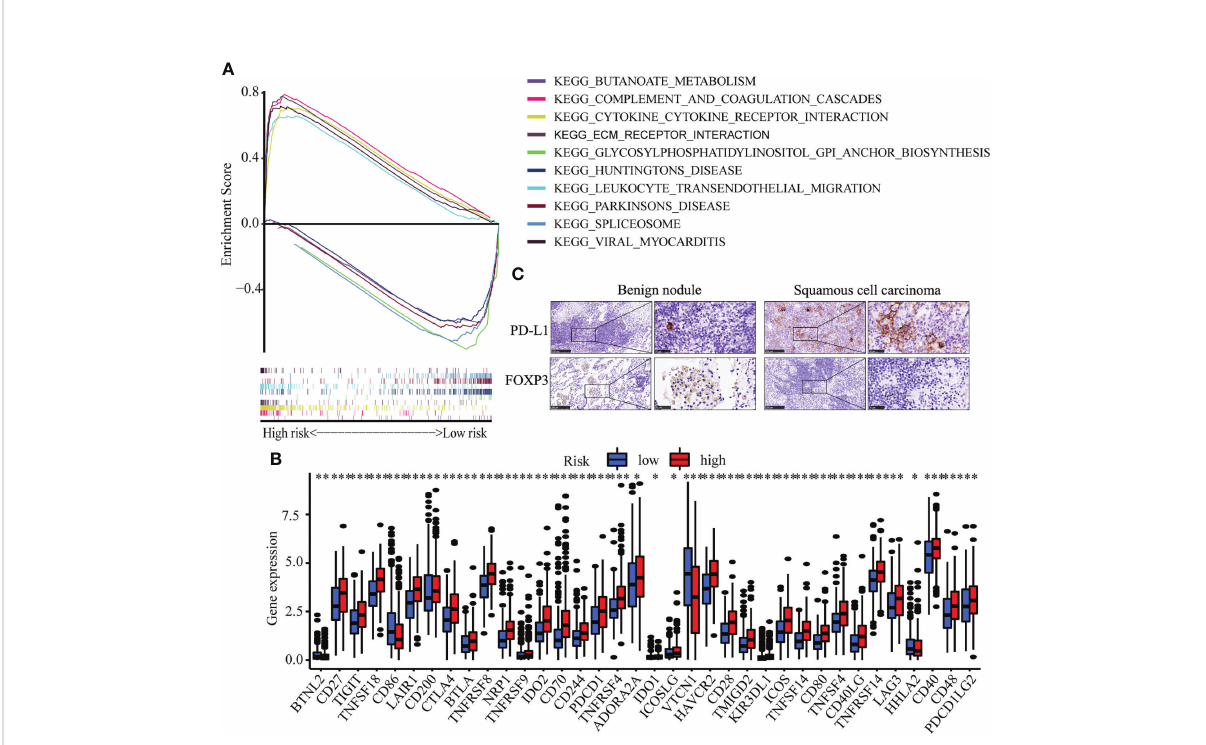
FIGURE 6 Immune cell in fi ltration in LUSC. (A) GSEA analysis between high risk and low risk groups. (B) The expression of immune check-point. (C) The Immunohistochemistry of CDKN1A and SOX2 between benign pulmonary nodule and LUSC. * means p<0.05; ** means